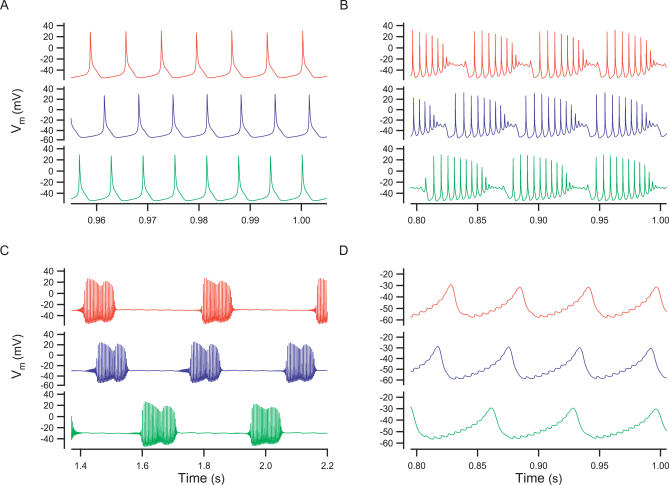
Comparison of the Models with the Data for Current Clamp(A–C) The membrane potential of the soma is shown for the data (red traces), best (blue), and worst (green) model of our selection for different somatic current amplitudes: 0.5 (A), 2 (B), and 3 nA (C).(D) Same as (B) for dendritic membrane potential.